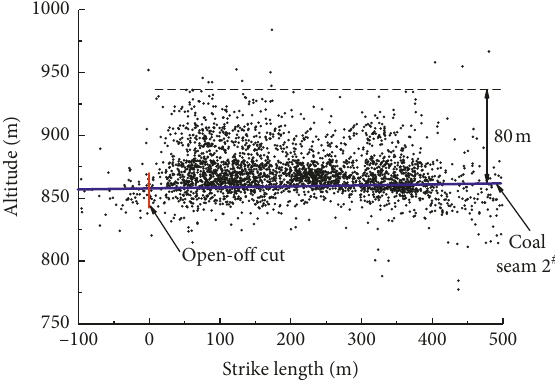
Figure 4: Location of microseismic events along the strike